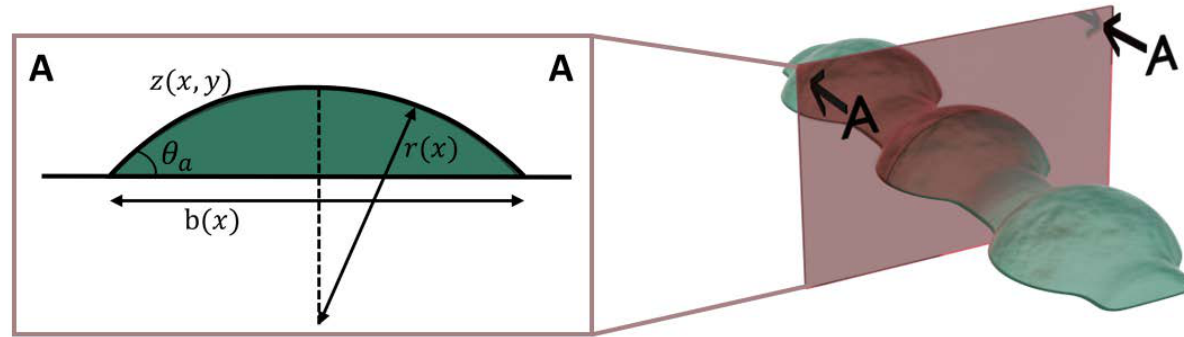
Figure 4. Cross-section of a bulge (inspired from [41]).